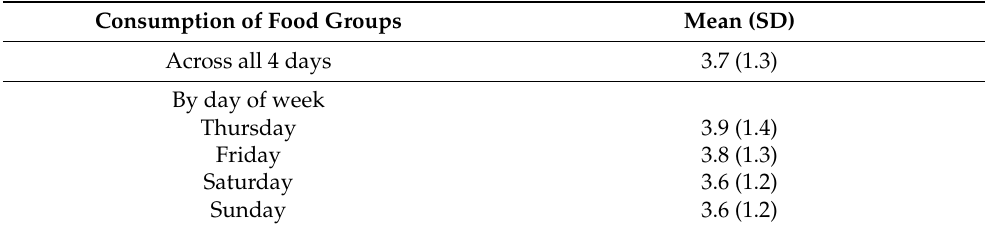
Table 2. Number of food groups recorded for infants ( n = 70) across the 4 days and by day of the week.